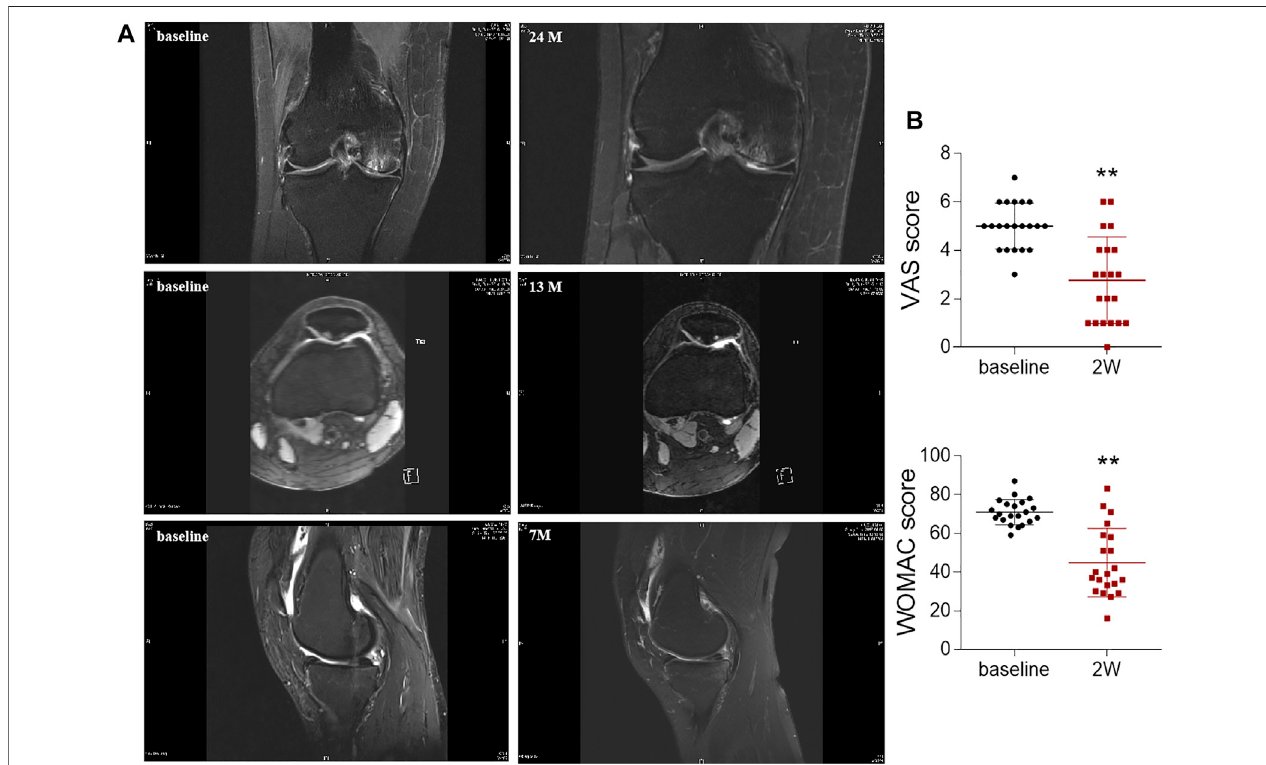
FIGURE 6 | Radiological imaging analysis and OA scoring of knee joints after ADSCs treatment. (A) Magnetic resonance imaging evaluation of knee joint after injection. (B) VAS and WOMAC scoresbefore (baseline) and after once intra-articularinjection ofADSCs at week2 (2 W).Values werepresentedas mean± SD. N = 21. ** p < 0.01 vs. Baseline